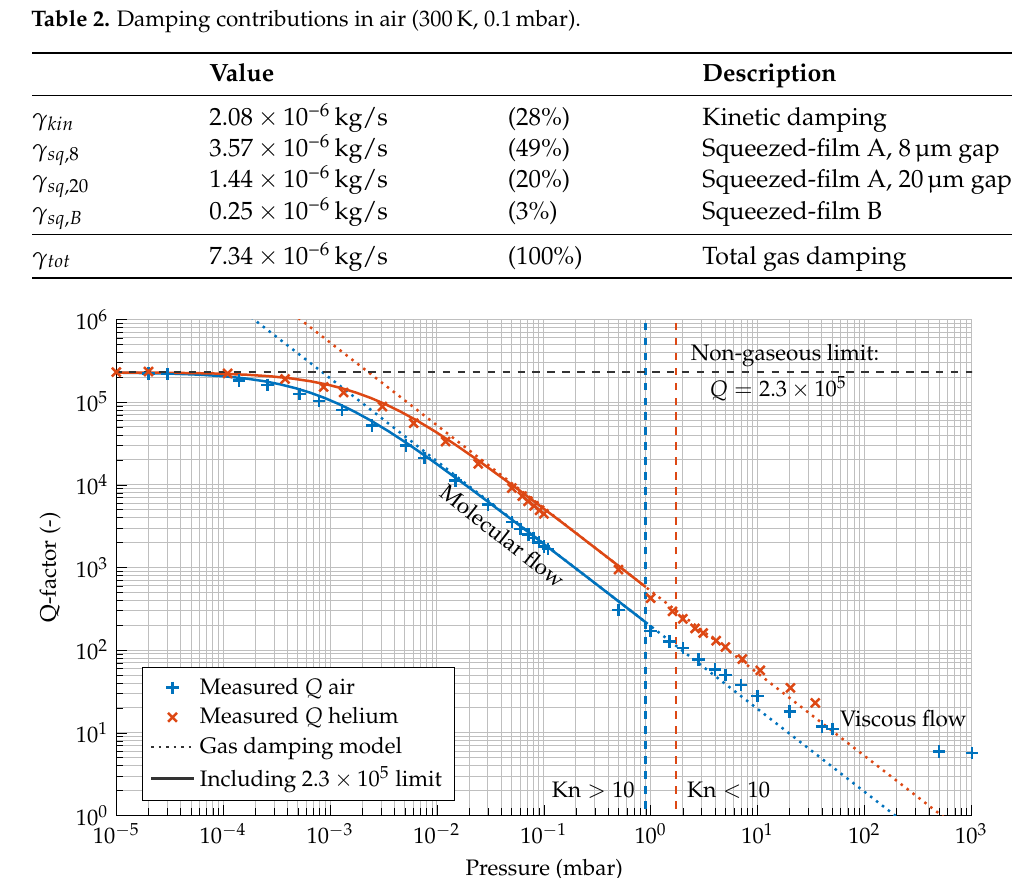
Figure 5. Q factor measurements for a MEMS accelerometer with a natural frequency of 183.3Hz in air and helium atmospheres at different pressures. The dotted curves represent the expected Q from the total modeled gas damping γ tot as a function of pressure. The model is valid for Kn > 10. The pressure was measured with two capacitive gauges, a CMR261 (10 −1 mbar to 10 3 mbar) and a CMR365 (10 −4 mbar to 10 −1 mbar), and a cold cathode gauge, IKR251 ( < 10 −4